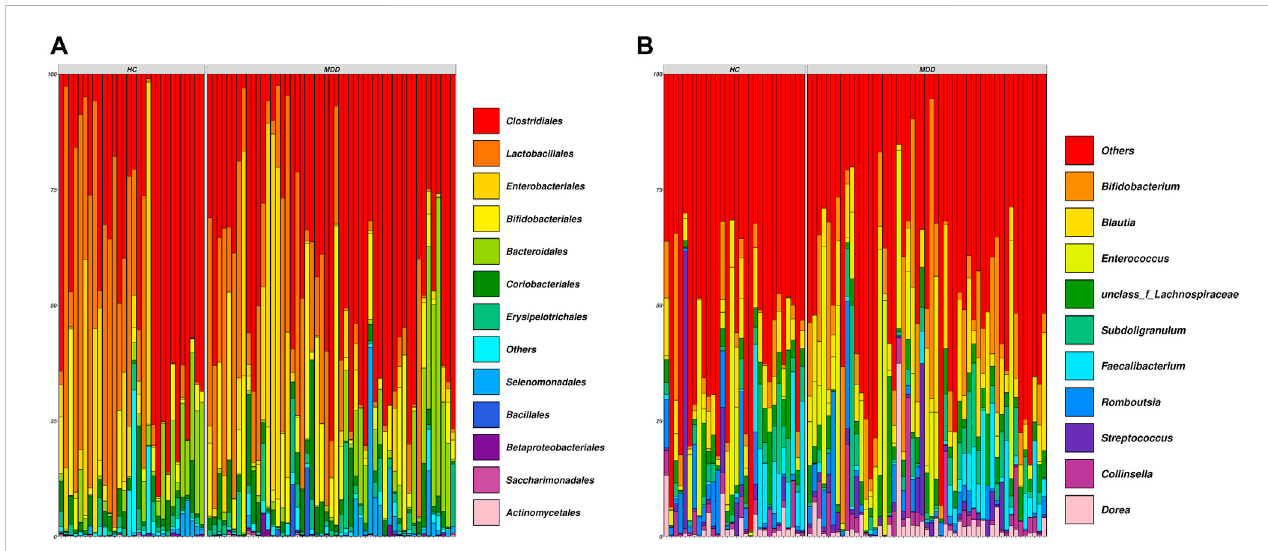
FIGURE 1 Composition of all samples in the cohort. (A) Family-level composition of samples. (B) Genus-level composition of samples. Each vertical line indicates one